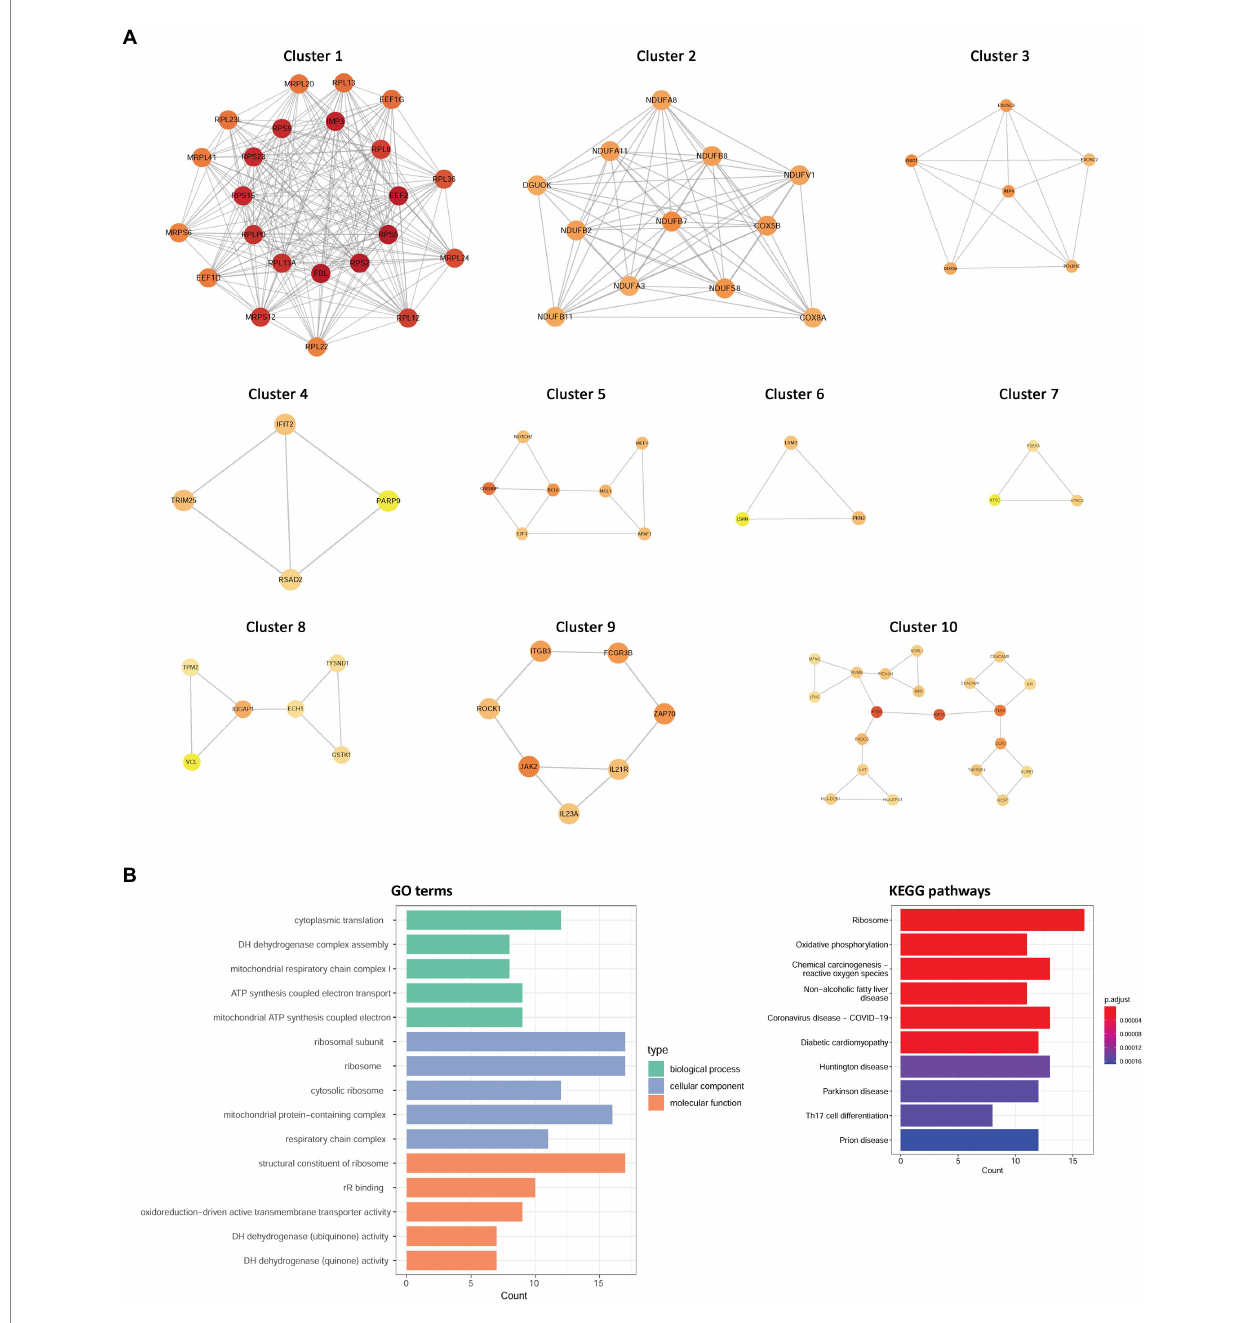
FIGURE 2 The clusters identified from the PPI network and functional enrichment analysis for cluster genes. (A) Ten clusters were identified from this PPI network. (B) GO term and KEGG pathway enrichment results. PPI, protein–protein interaction; GO, Gene Ontology; KEGG, Kyoto Encyclopedia of Genes and